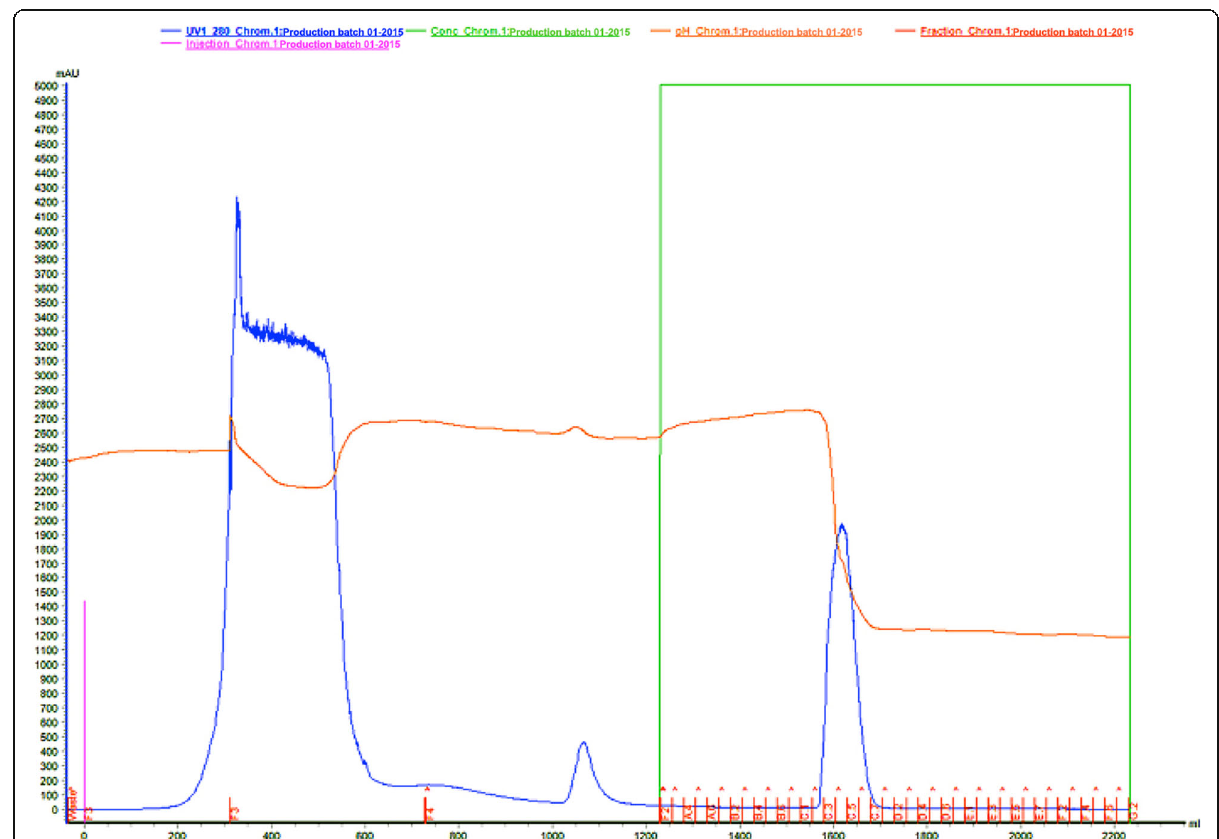
Fig. 5 Affinity liquid chromatography of Crotalus durissus terrificus crude venom with Benzamidine-Sepharose 6B resin (column AxiChrom 100/ 300® (100 mm × 300 mm × 350 mL). The column was equilibrated with 0.05 M Tris-HCl pH 7.4 (buffer 1). Sample: 15 g of crude venom was suspended in buffer 1. The sample elution was carried out with 525 mL of buffer 1 followed by 525 mL of 0.05 M Tris-HCl/0.5 M NaCl pH 7.4 (buffer 2) and 1,050 mL of 0.02 M glycine pH 3.2 (buffer 3), at flow rate 10 mL/min, and collected 25 mL/tube. Absorbance 280